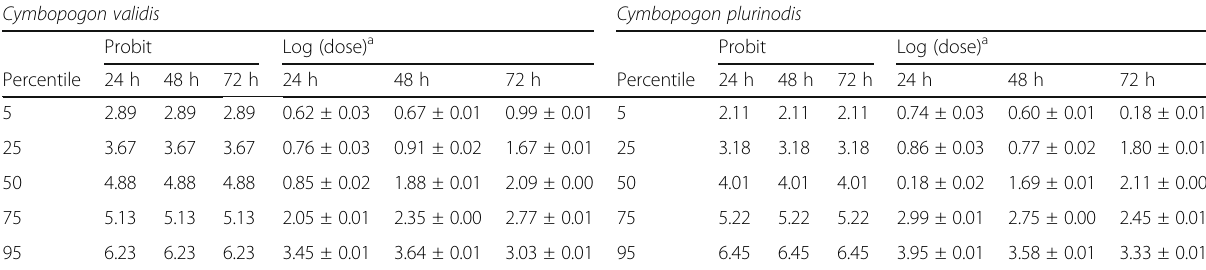
Table 5 Effective concentration and time interval on the percentage cell death Cymbopogon